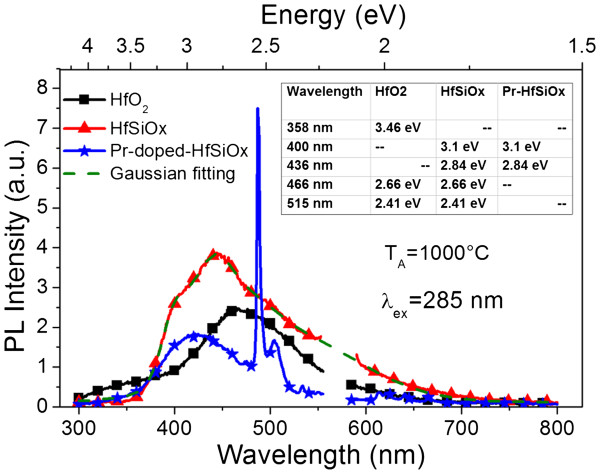
PL spectra of Pr-doped and undoped HfSiOxand undoped pure HfO2films excited at 285 nm. The films were annealed at 1,000°C. Inset table is data of the fitting peaks.